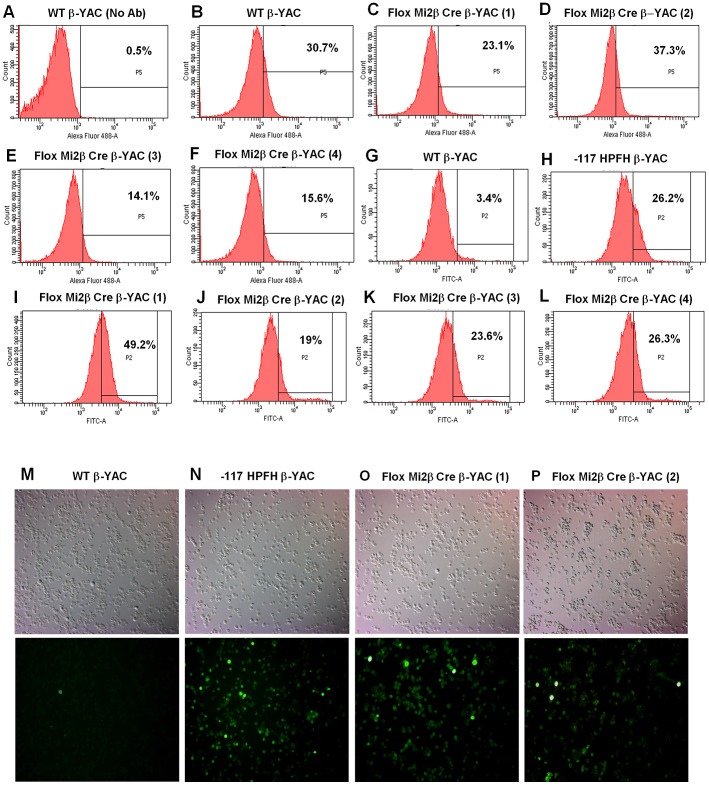
Flow cytometry and cytospin analysis of blood from adult erythroid-specific Mi2β conditional knockout β-YAC transgenic mice.A rabbit polyclonal anti-Mi2 antibody+secondary antibody (panels A–F) or an anti-human hemoglobin F FITC-conjugated antibody (panels G–L) was used to determine the percentage of cells expressing of Mi2 or HbF, respectively. Cytospins were prepared using an anti-human hemoglobin F FITC-conjugated antibody (panels M–P). Antibody employed, followed by sample: A) IgG control, wild-type β-YAC; B) Mi2, wild-type β-YAC; C–F) Mi2, floxed Mi2β μ'LCR β pr-Cre β-YAC 1, 2, 3 and 4, respectively; G) HbF, wild-type β-YAC; H) HbF, −117 Greek HPFH β-YAC; I–L) Mi2 floxed Mi2β μ'LCR β pr-Cre β-YAC 1, 2, 3 and 4, respectively. Cytospins: M) wild-type β-YAC; N) −117 Greek HPFH β-YAC; O–P) floxed Mi2β μ'LCR β pr-Cre β-YAC 1 and 2. Top panels, visible light images of cytospin cells; bottom panels, immunofluorescent images of same fields.